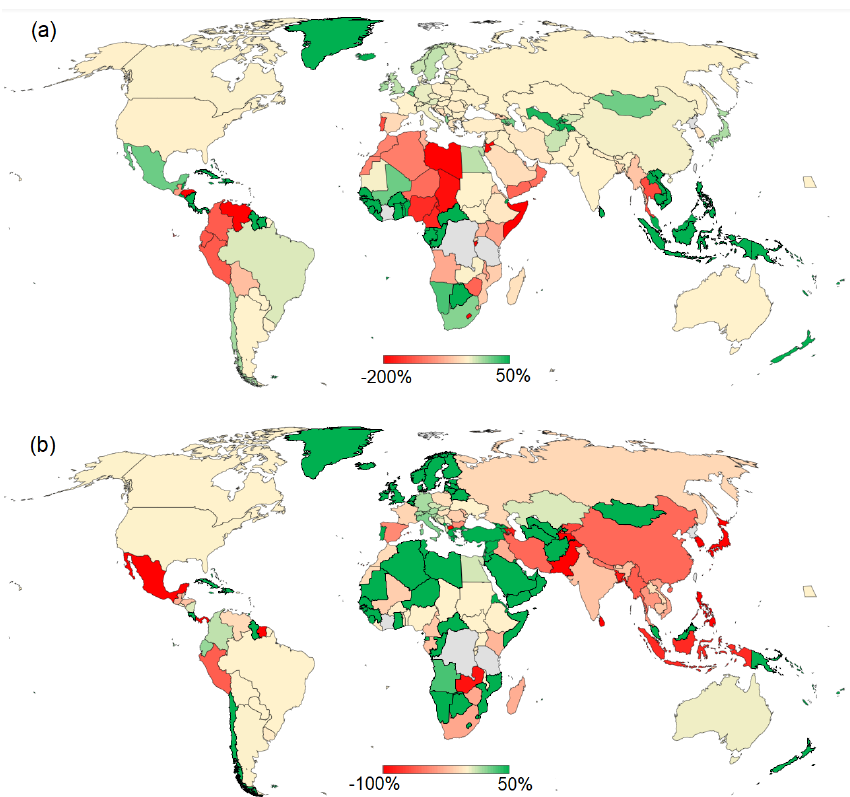
Figure 5. Percentage difference between the uWF of production and supply of wheat (a) and soybean (b) in the year 2016, calculated as the difference between uWFs and uWFp, normalized by uWFs. Bold green countries do not produce the crop; hence they only have a supply-side uWF. (Maps are created with Microsoft Power Map for Excel,